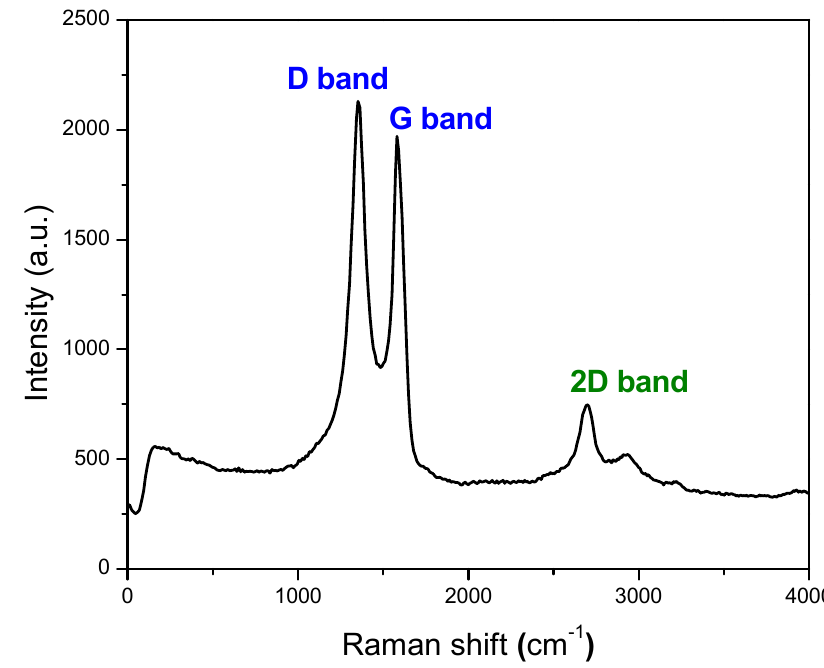
Figure 4. The Raman spectrum of EGr material.